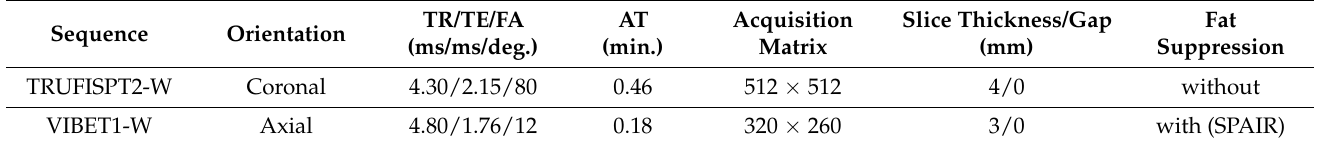
Table 2. MR Sequence